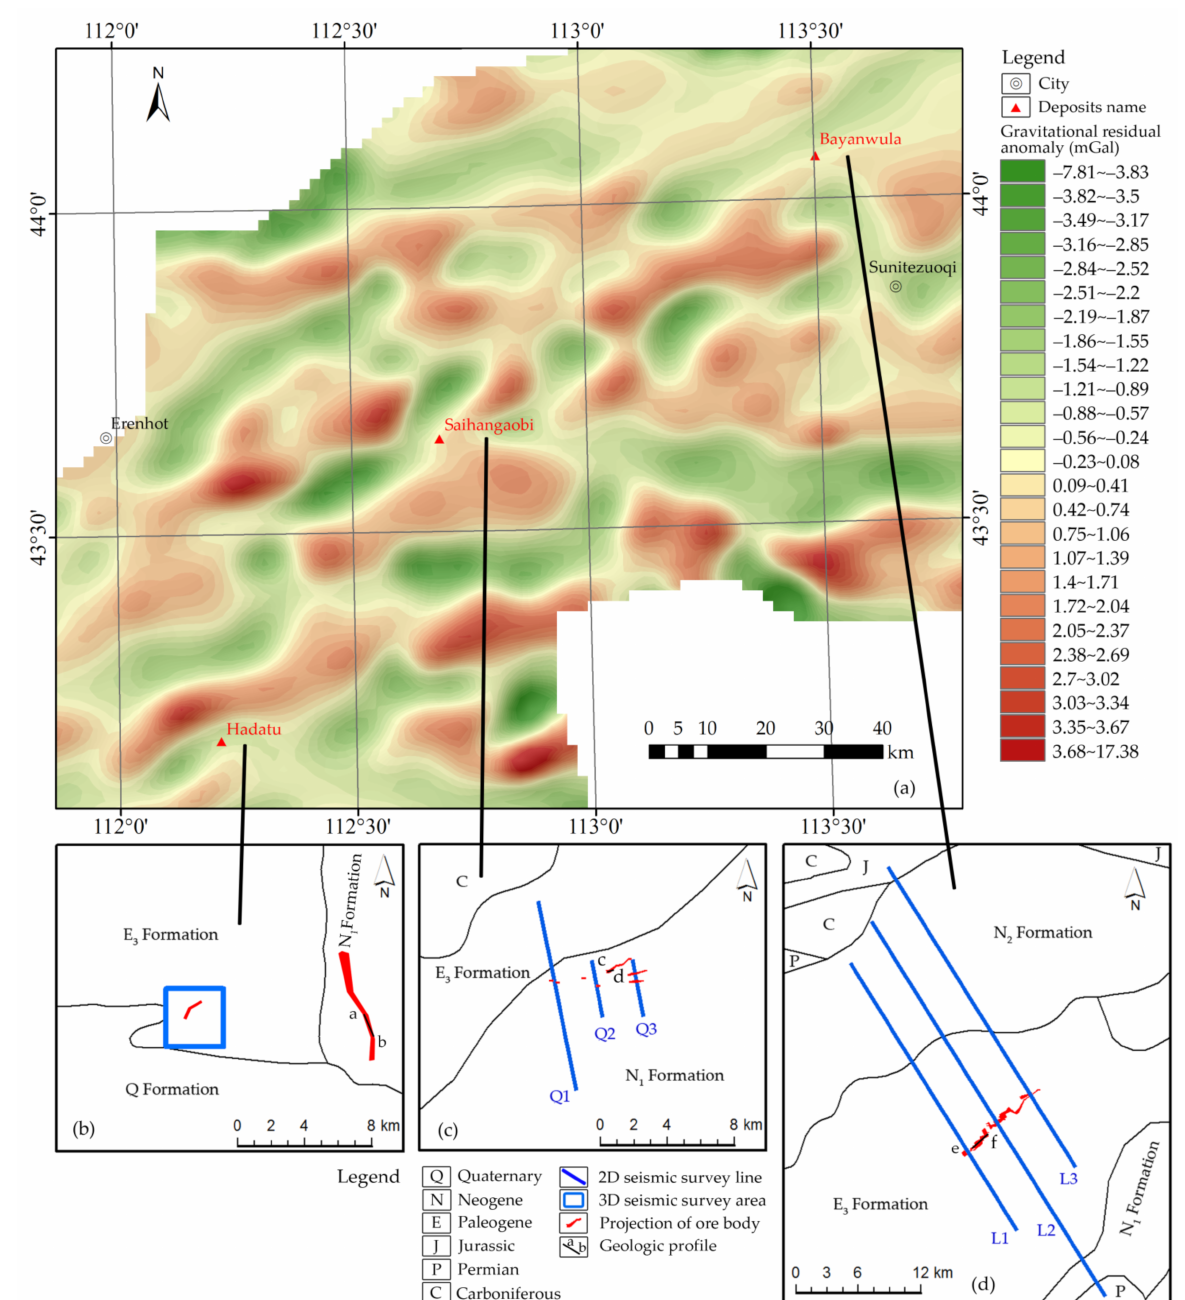
Figure 5. ( a ) Map of gravitational residual anomalies and the deposits’ positions in the study area. ( b ) The area of 3D seismic surveys performed in the Hadatu deposit. ( c ) The lines of the 2D seismic survey performed on the Saihangaobi deposit, and ( d ) the lines of the 2D seismic survey performed on the Bayanwula